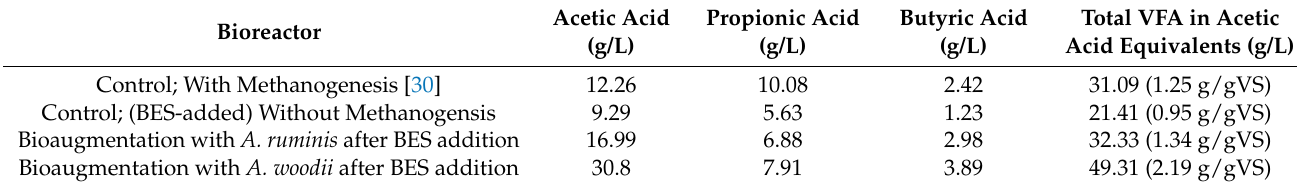
Table 2. Volatile fatty acids concentrations (g/L) in bioreactors with and without bioaugmentation and with 10 mM BES added. The bioreactors with and without methanogenesis were regarded as controls.